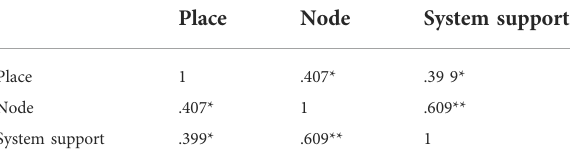
TABLE 6 Descriptive statistics of the node, place, and system support